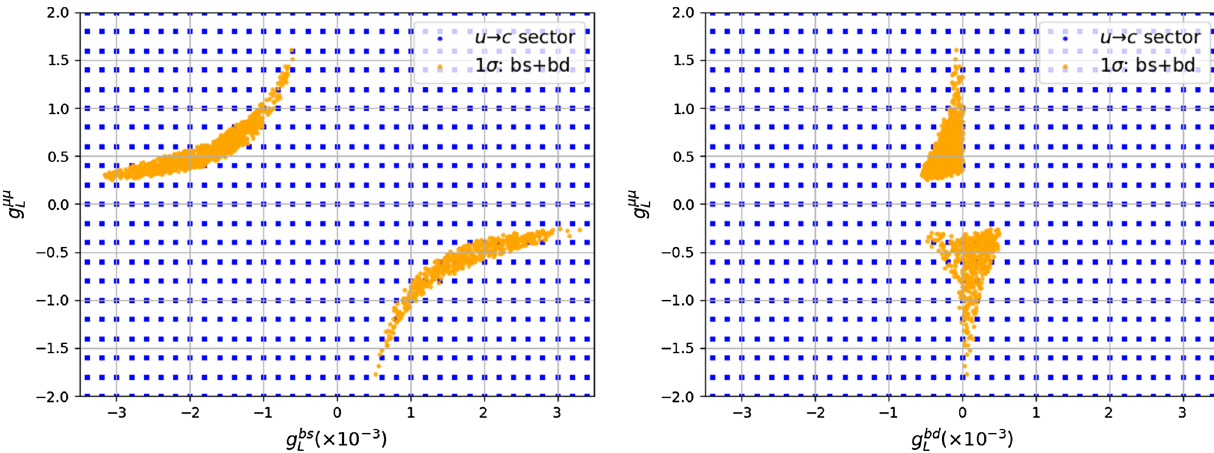
¯ D 0 mixing & branching ratio of D 0 → μ + μ − and combined b → s , b → d and